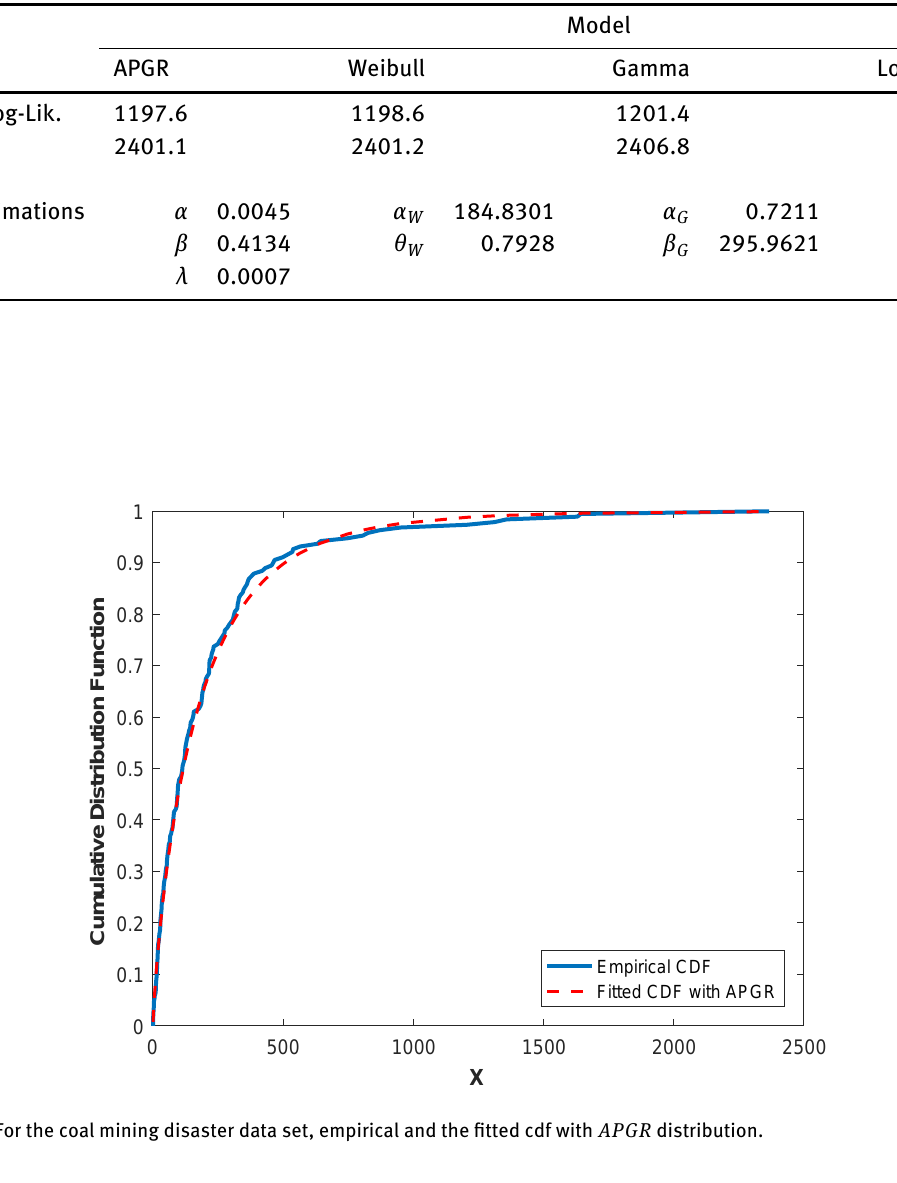
Table 4: Model comparison and parameter estimates for the coal mining disaster data set.